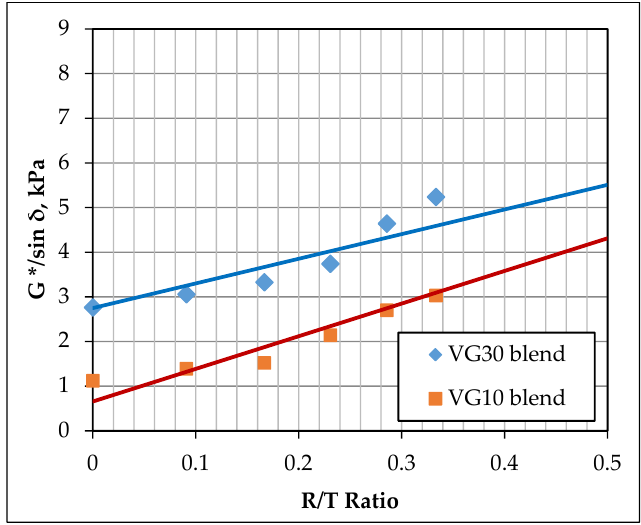
Figure 2. Variation of G */sin δ with R/T Ratio.